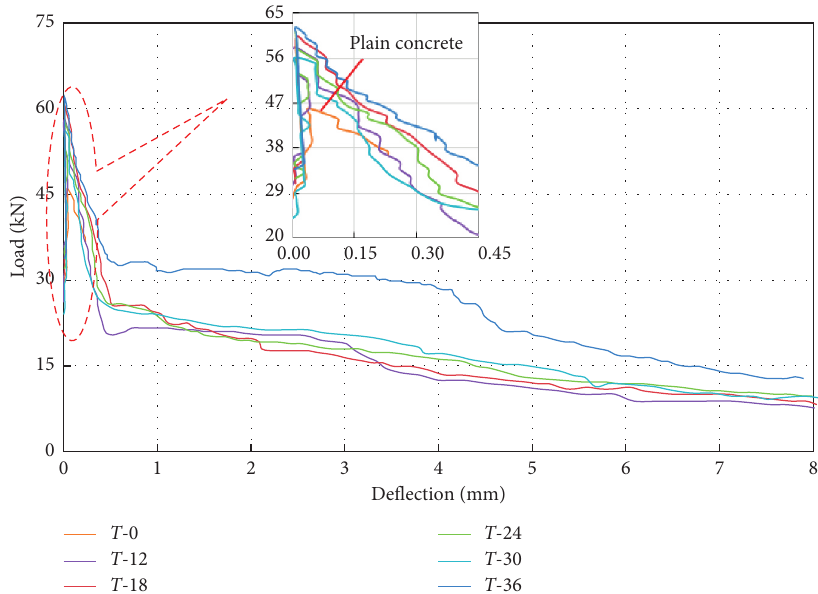
Figure 5: The load-deflection curves of tire-recycled steel fiber reinforced